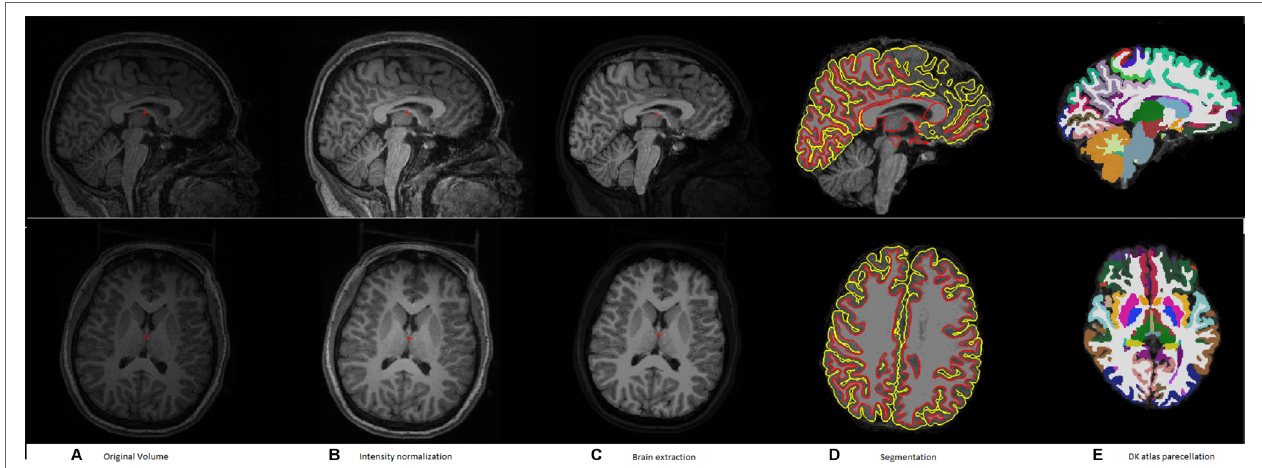
FIGURE 1 | A typical example of the pipeline applied to an input volume to prepare it for feature extraction. (A) Original volume, (B) intensity normalization, (C) brain extraction, (D) segmentation, and (E) DK atlas